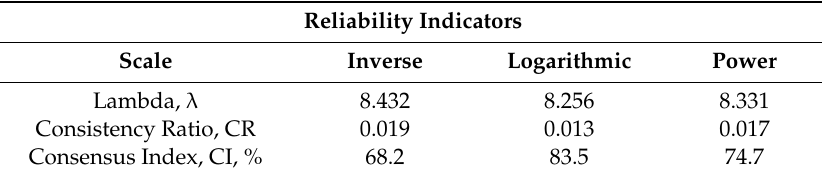
Table 1. Research reliability indicators.